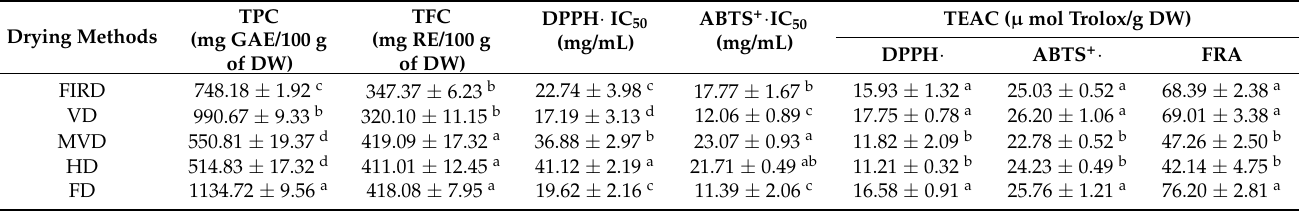
Table 2. Total phenolic content, total flavonoid content, and antioxidant activities of dried